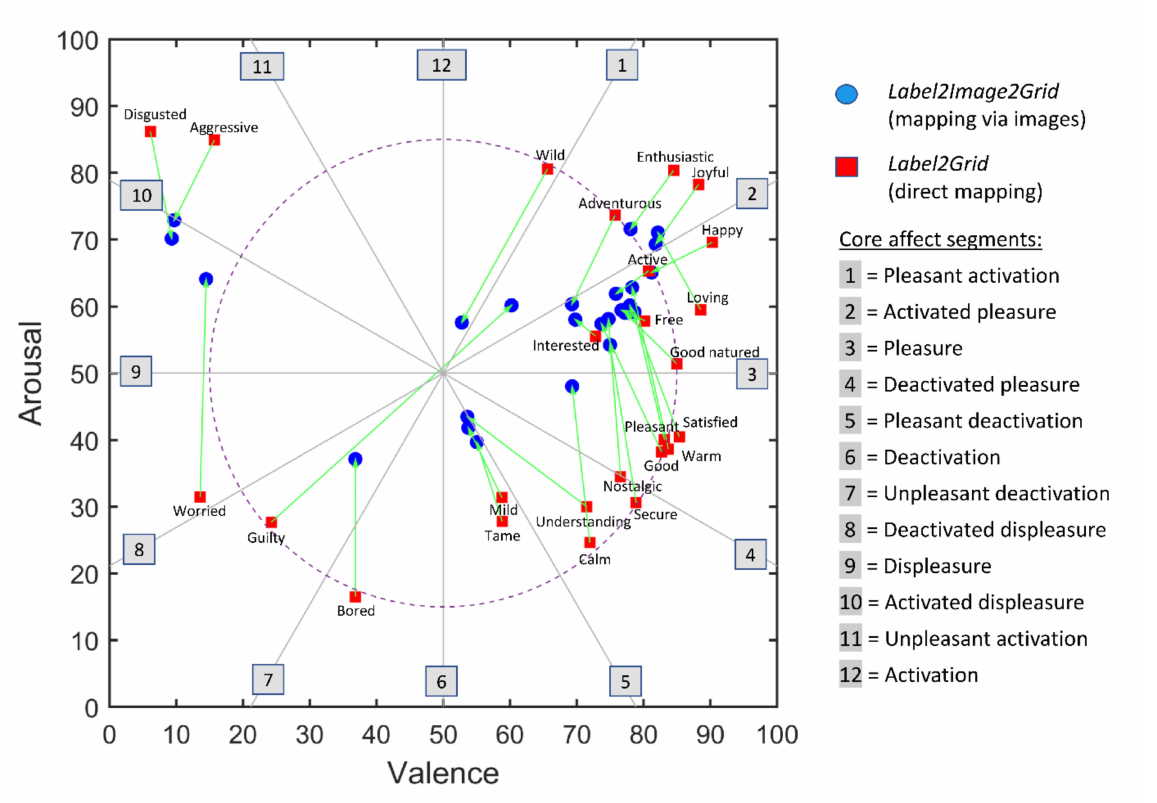
Figure 12. Mapping the EsSense25 terms to the EmojiGrid. Red symbols represent the average positions of the emotion terms that were directly mapped to the EmojiGrid in Label2Grid task. Blue symbols represent the average positions of the emotion terms that were mapped to the EmojiGrid via the food images ( Label2Image task followed by Image2Grid task). Green arrows connect corresponding terms obtained through direct and indirect mapping. The gray labels correspond to the 12 domains (delineated by the gray radial axes) of the core affect model presented by Yik et al. [27]. The dashed circle serves as a visual reference for the eccentricity of the data